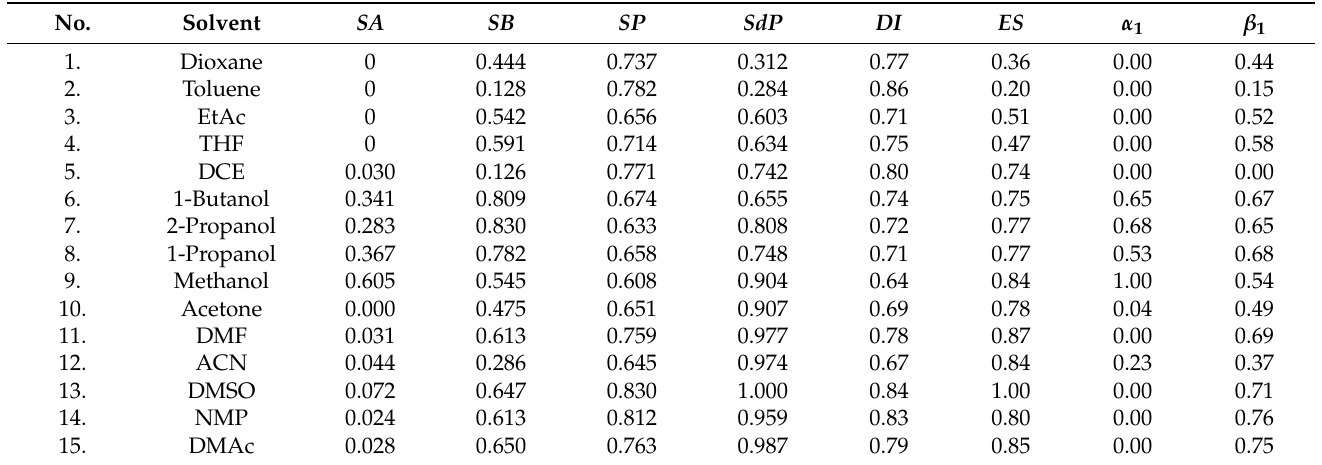
Table 2. Empirical Catal á n { SA, SB, SP , and SdP } and Laurence { DI, ES, α 1 , and β 1 } solvent parameters